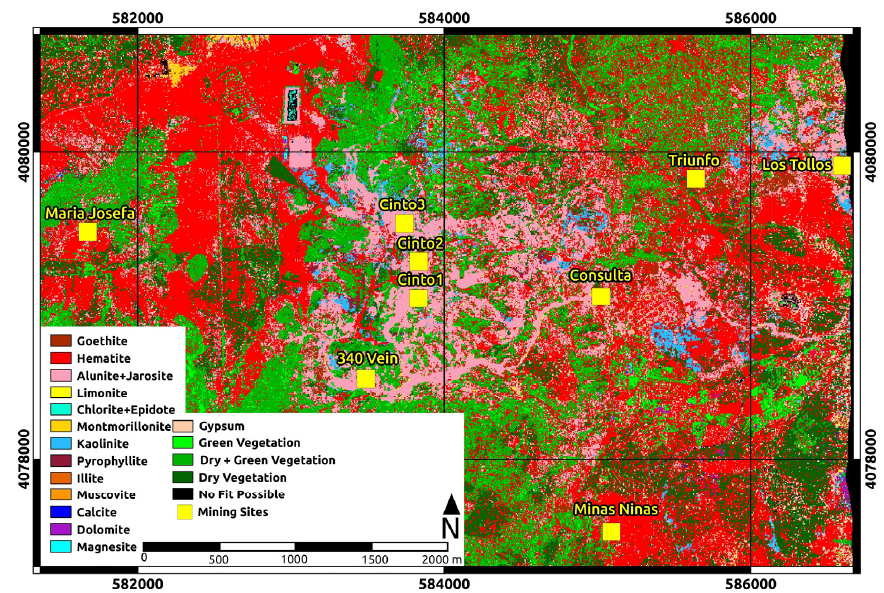
Figure 10. Best weighted fit material map of EnGeoMAP 2.0 calculated from airborne HyMAP data, which was used as simulation input to produce the EnMAP data.